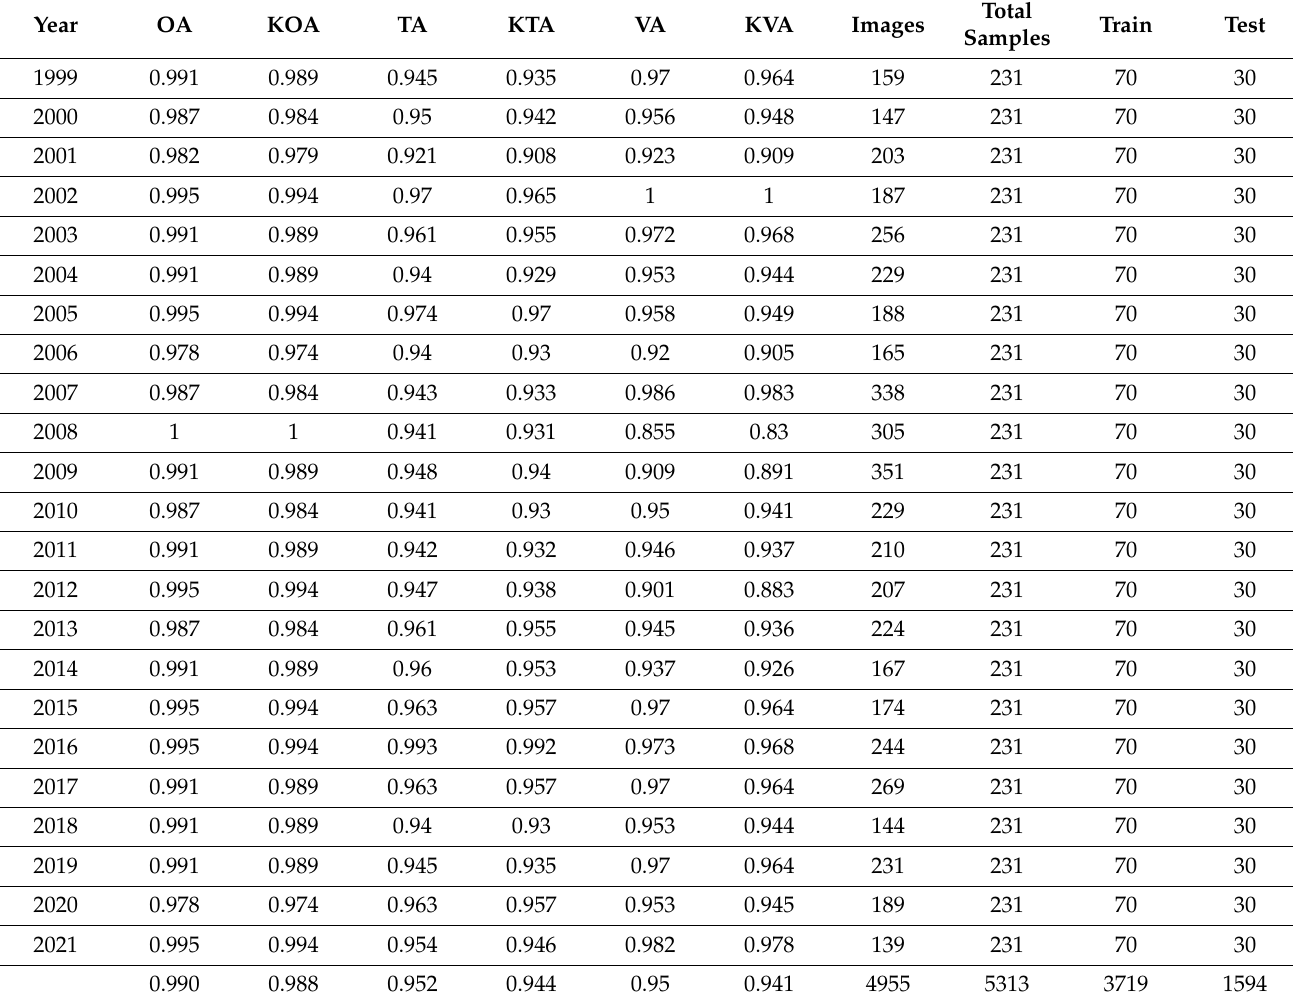
Table 2. Random forest classification accuracy over the Great Salt Lake Basin. Where OA is overall accuracy, KOA is the kappa overall accuracy, TA is the training accuracy, KTA is kappa training accuracy, VA is the validation accuracy, and KVA is kappa validation